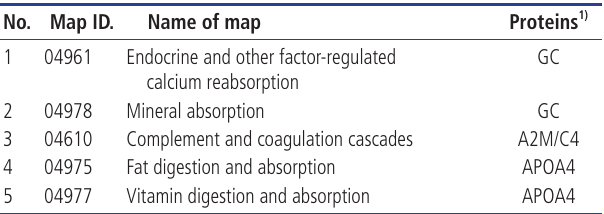
Table 3. Pathway analysis No. Map ID.